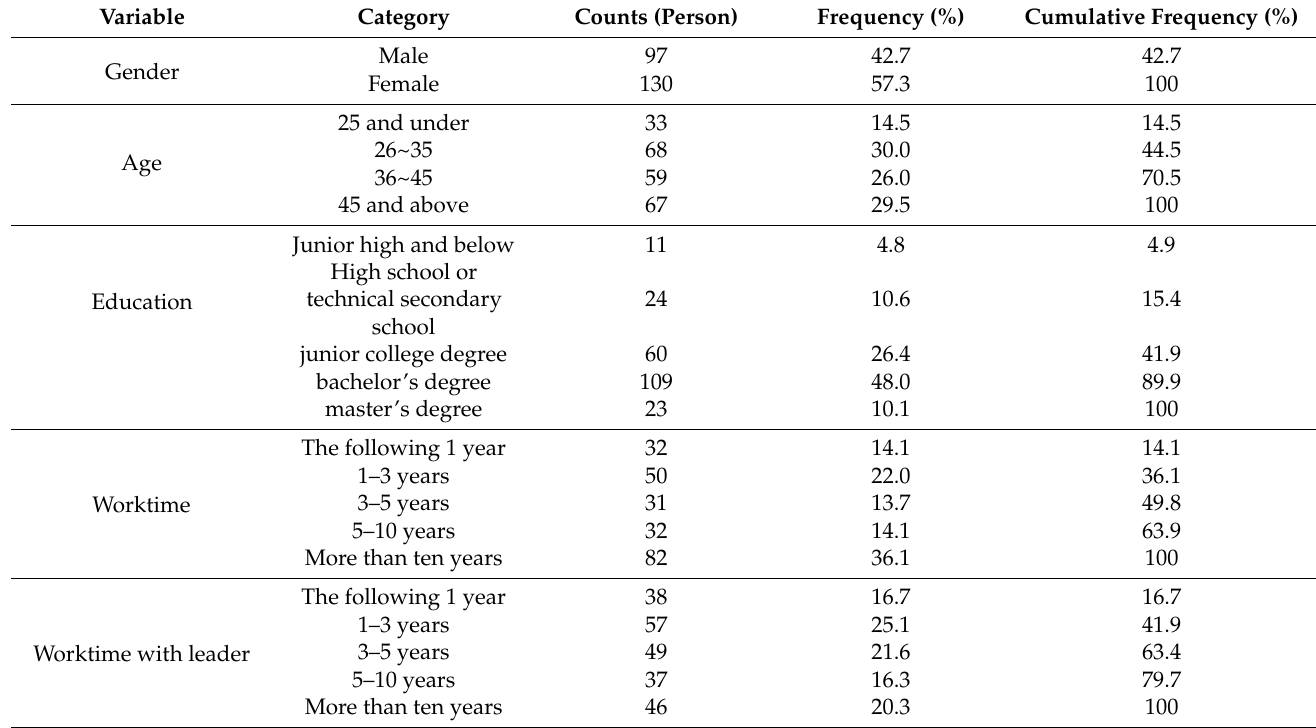
Table A2. Study 2 Valid sample